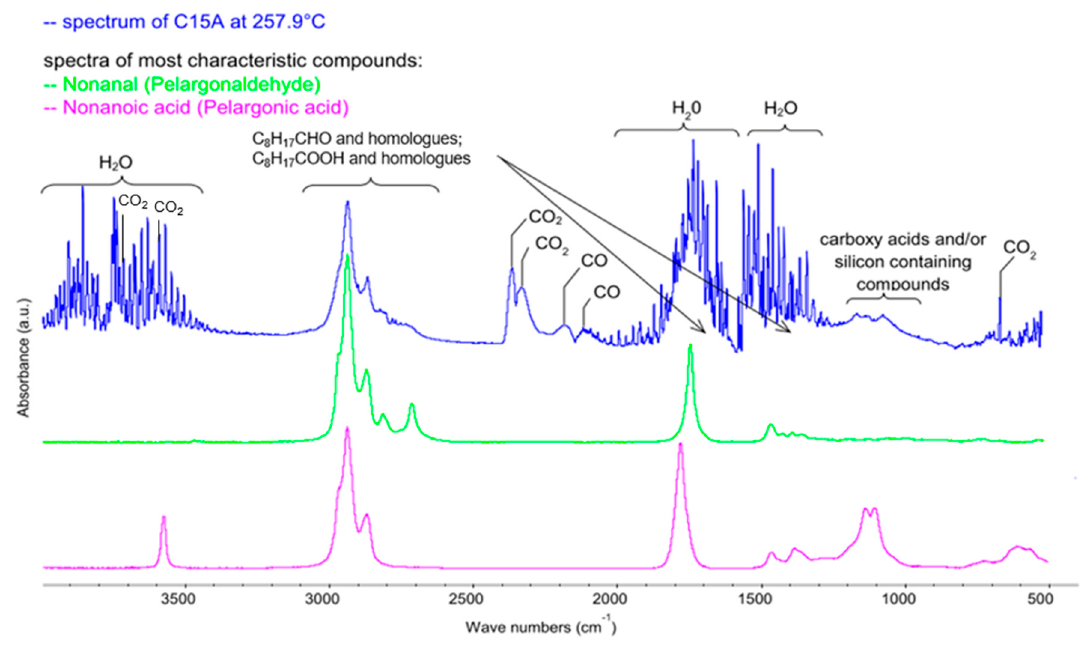
Figure 4. FTIR spectrum of gases evolved during oxidative degradation of C15A recorded at 257.9 °C (blue) with spectra of the most representative compounds from the group of aldehydes and acids—nonanal (green) and nonanoic acid (pink), respectively, present in products at the above temperature. Qualitative characteristics of the spectrum were obtained using Nicolet ™ FTIR Vapor Phase Spectral Library software.